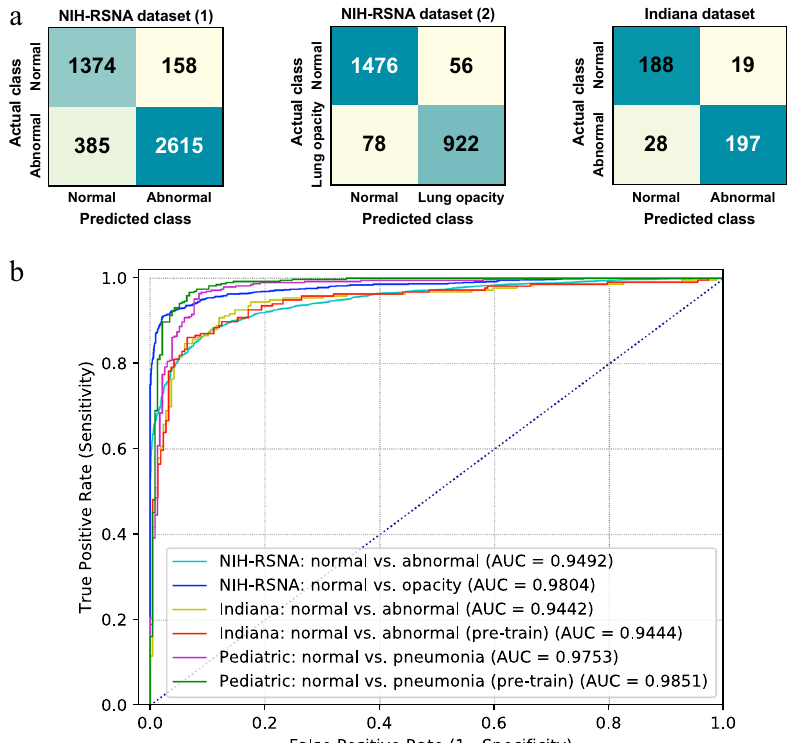
Fig. 3 Model performance on different datasets and tasks. a Confusion matrices of VGG-19 CNN model performance on different datasets. Left: RSNA challenge dataset for normal versus abnormal classi fi cation. Middle: RSNA challenge dataset for normal versus lung opacity classi fi cation. Right: Indiana dataset for normal versus abnormal classi fi cation. b ROCs of CNN models ’ performance on different datasets and tasks. Pre-train: CNNs pre-trained on the NIH “ ChestX-ray 14 ” dataset for normal versus abnormal classi fi cation as weight initialization.